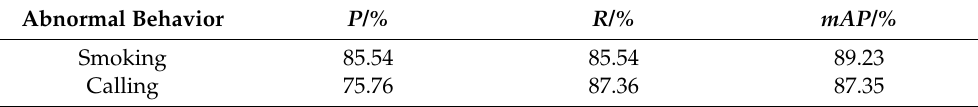
Table 4. Evaluation indicators of behavior